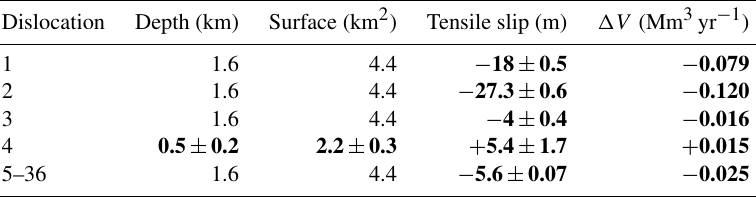
Table 1. Parameters used in the best-fit multiple tensile dislocations model presented in Fig. 8. Dislocations inside the most intensively exploited part of the oil field are numbered from 1 to 4. Parameters adjusted during the inversion are plotted in bold characters together with their uncertainties. We convert the amount of tensile slip on each dislocation (column 4) into an equivalent volume (column 5) to compare with the results from the poroelastic